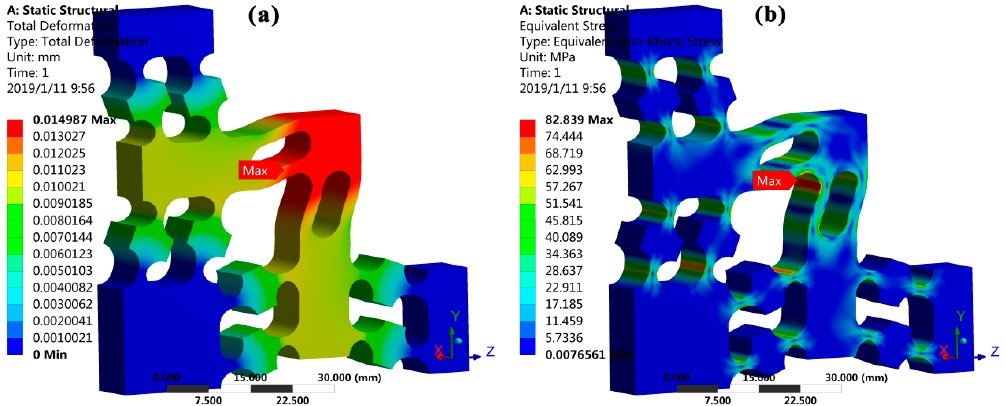
Figure 7. The static analysis of the developed 2-DOF PDCM. ( a ) Displacement nephogram and ( b ) stress nephogram.